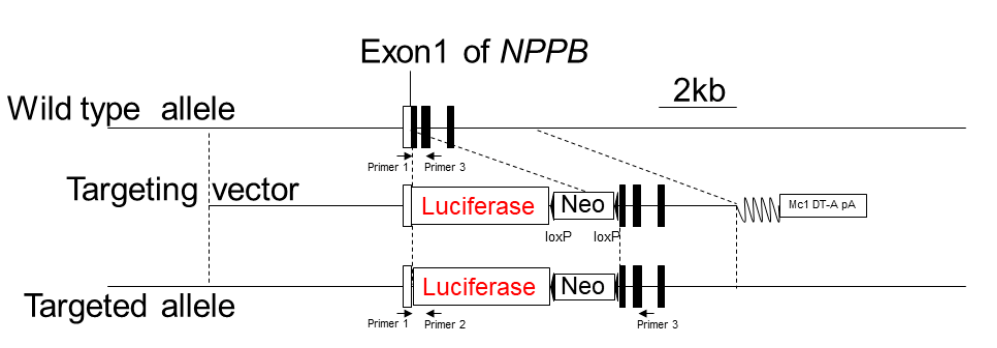
Figure 1. Targeting strategy by homologous recombination. Structures of the wild-type allele ( top row), gene targeting vector ( middle row ) and targeted allele ( bottom row ) are shown. DT-A, diphtheria toxin-A cassette; Neo, neomycin cassette; NPPB , natriuretic peptide B gene.